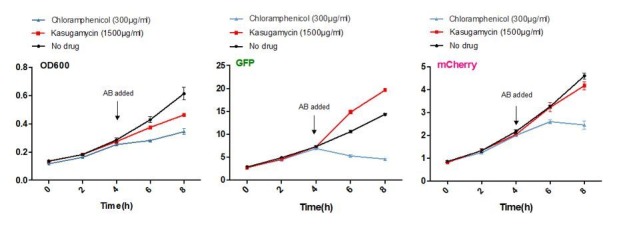
Kasugamycin does not significantly inhibit translation of a canonical or leaderless transcript in M. smegmatis at doses much higher than required to reduce mistranslation.A strain of M. smegmatis was transformed with an episomal plasmid expressing gfp from the promoter Psmyc (canonical promoter with 5’ UTR) and a leaderless version of Psmyc driving mCherry. Chloramphenicol inhibited translation of both transcripts, whereas kasugamycin at 1500 µg/ml failed to significantly attenuate translation from either transcript.